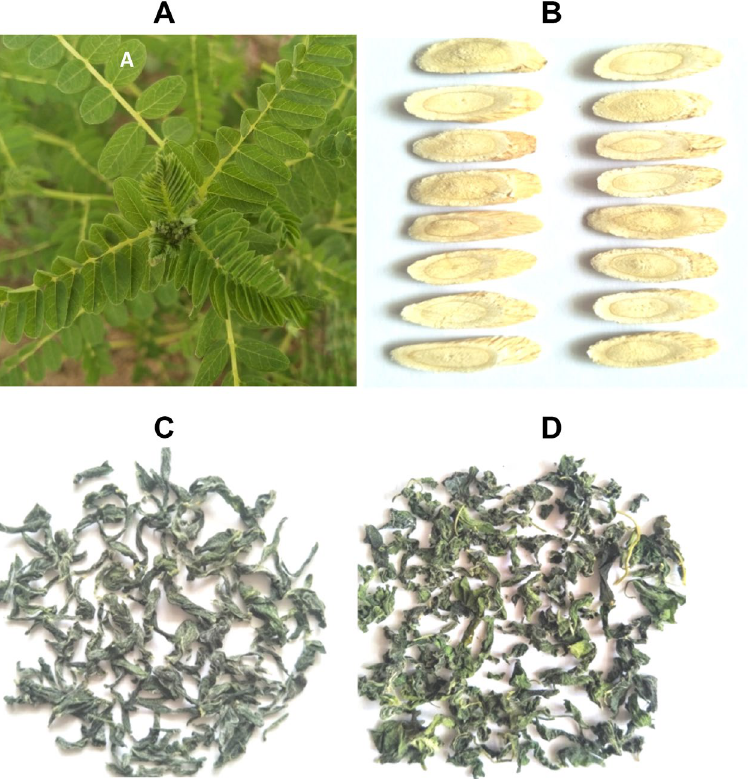
Figure 1. Morphology of plant leaves growing in a field ( A ), dry roots ( B ), leaf tea ( C ) and dry leaves ( D ) processed from A. membranaceus